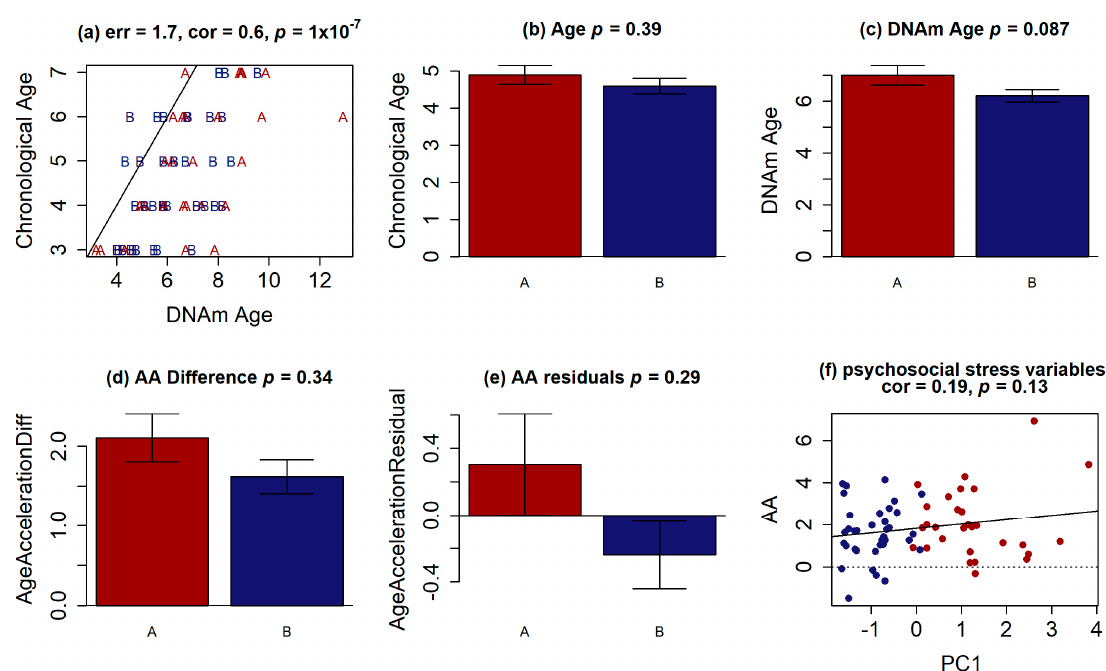
Figure 4. Age Acceleration analysis. ( a ) Scatter plot of chronological age ( y -axis) and DNA methylation age ( x -axis) each point represents a sample analyzed. Bar plot comparing ( b ) chronological age, ( c ) DNA methylation predicted age ( d ) Age acceleration difference (DNAm–Age) ( e ) Residual calculation from a linear model (DNAm~Age), the p -values represented at the top level in each graphics (Mann-Whitney test). ( f ) Scatter plot of age acceleration ( y -axis) and PC1 ( x -axis) which resumes the psychosocial stress each point represents a sample analyzed. In all graphics, group A is red and group B blue.